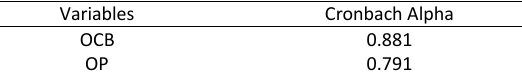
Table 1: Reliability test of constructs